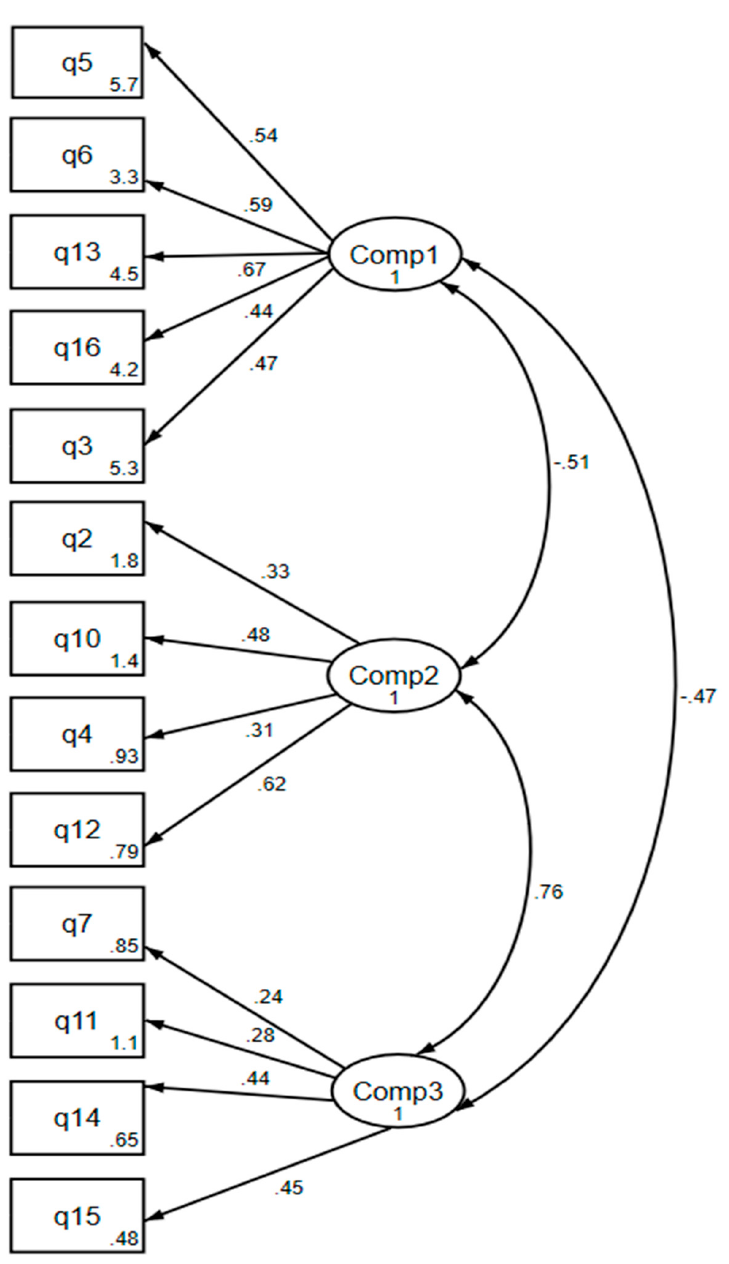
Figure 3. The confirmatory factor analysis of the Romanian version of TEQ with a 3-factor structure. Legend: numbers on the double-headed arrows represent the covariance between components, numbers on the single-headed arrows represent the standardized factor loadings. the components are: component1 = pro-social helping behavior, indifference, component2 = inappropriate sensitivity, component3 = dismissive attitude.